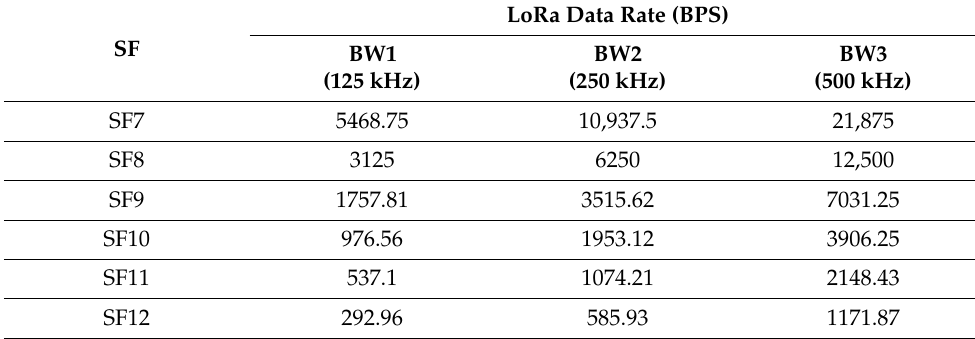
Table 5. LoRa data rate/bit rate at CR1.